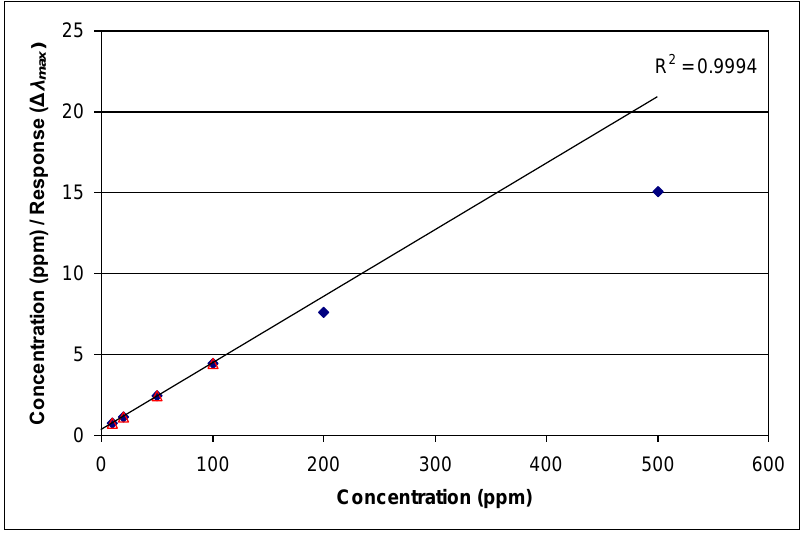
Figure 3. Example of linearization of data for 2,2,4-trimethylpentane, showing closer adherence to simple Langmuir